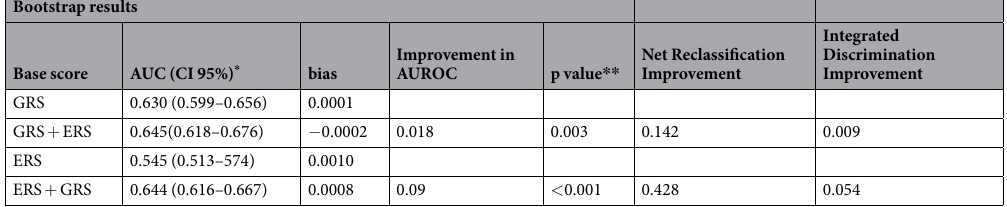
Table 3. Improvement in risk prediction when adding more component scores. * AUC estimates bias- corrected confidence interval 95%. ** p value for the improvement in AUROC. GRS: Genetic Risk Score. ERS: Environmental Risk Score.